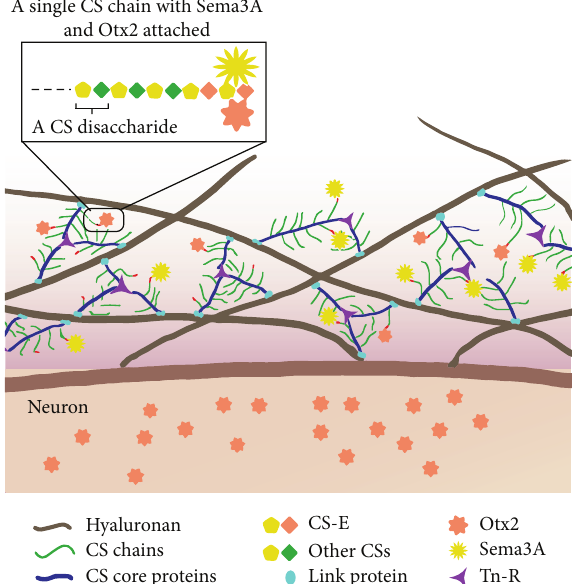
Figure 4: Schematic representation of Sema3A protein localization in PNNs. Hyaluronan molecules attached to the neuron cell mem- brane contain link proteins that carry the CS chain bearing CS core proteins. Tn-R act as a cross-linking protein between several CS core proteins present on different hyaluronan molecules. Both Sema3A and OTX2 preferentially bind to the CS-E chains attached to the CS core proteins. After binding to the PNN via CS-E, OTX2 can translocate into the neuron [53, 54], whereas Sema3A appears to reside in the PNN using CS-E as “an